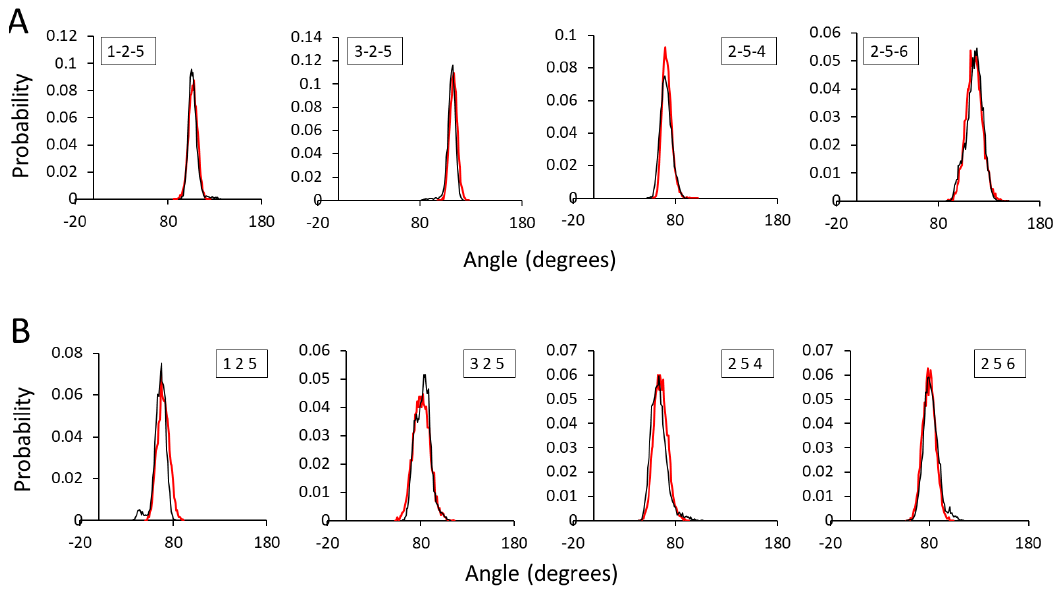
Figure 3. Angle distributions of AA and CG representations for ( A ) HA1-3 and ( B ) HA1-4. Black and red lines indicate AA and CG representations, respectively.